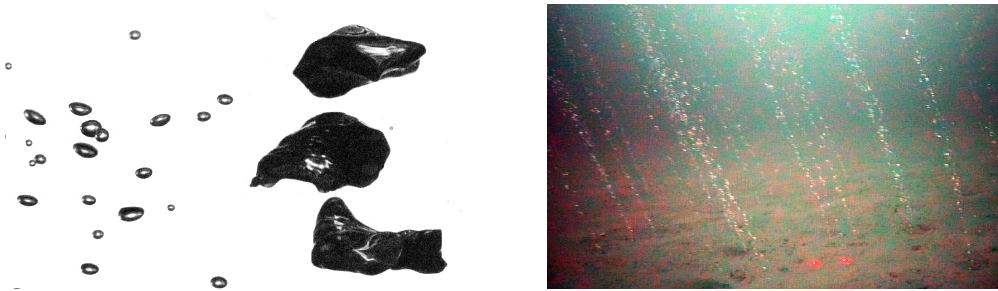
Figure 1. The shape and speed of gas bubbles rising in a liquid depends on the bubbles’ volume and surface area and other (physical and chemical) properties of gas and liquid [3]. For instance, air bubbles in water are almost spherical up to millimeter size (small bubbles to the left ), become approximately ellipsoidal in the several millimeter range and can be irregularly shaped when much larger. The image to the right shows an area in the North Sea where methane is released from the ocean floor and forms distinct bubble streams. Measuring the flux, the rise speed, and the bubble size distribution is of crucial importance for larger scale ocean and atmosphere